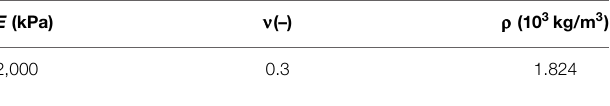
TABLE 4 | Gabion-boxes properties.